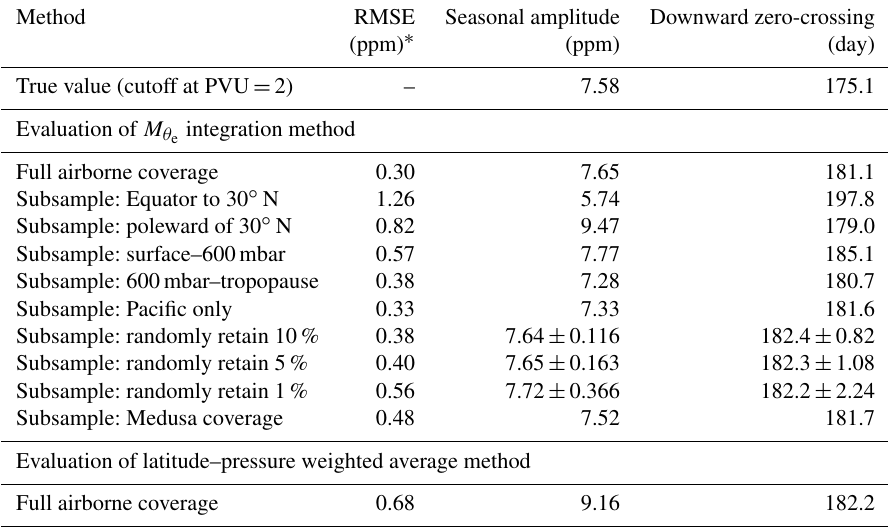
Table 3. RMSE, seasonal amplitude, and day of year of the downward zero-crossing of each simulation based on the Jena CO 2 inversion. The true value (daily average CO 2 ) is computed by integrating over all tropospheric grid cells of the Jena CO 2 inversion, while troposphere is defined by PVU < 2 from ERA-Interim. Seasonal amplitude and downward zero-crossing of true average and each simulation is computed from two-harmonic fit to the detrended value, which is detrended by subtracting the MLO cubic stiff spline. Subsampling with randomly retaining a certain fraction of data are conducted by randomly subsampling 1000 times, thus, the seasonal amplitude and day of year of the downward zero-crossing is computed as the mean ± standard deviation of the 1000